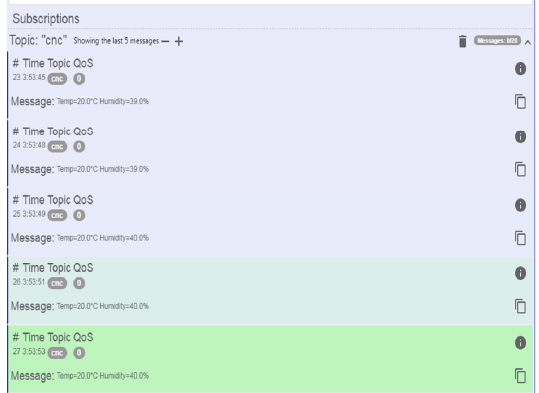
Fig. 9. Final part produced by CNC machine.